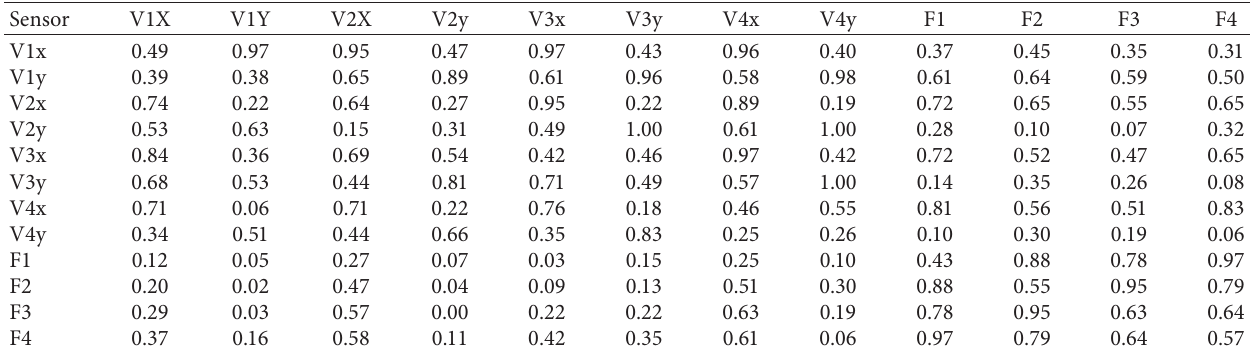
Table 3: Correlation coefficient matrix at normal